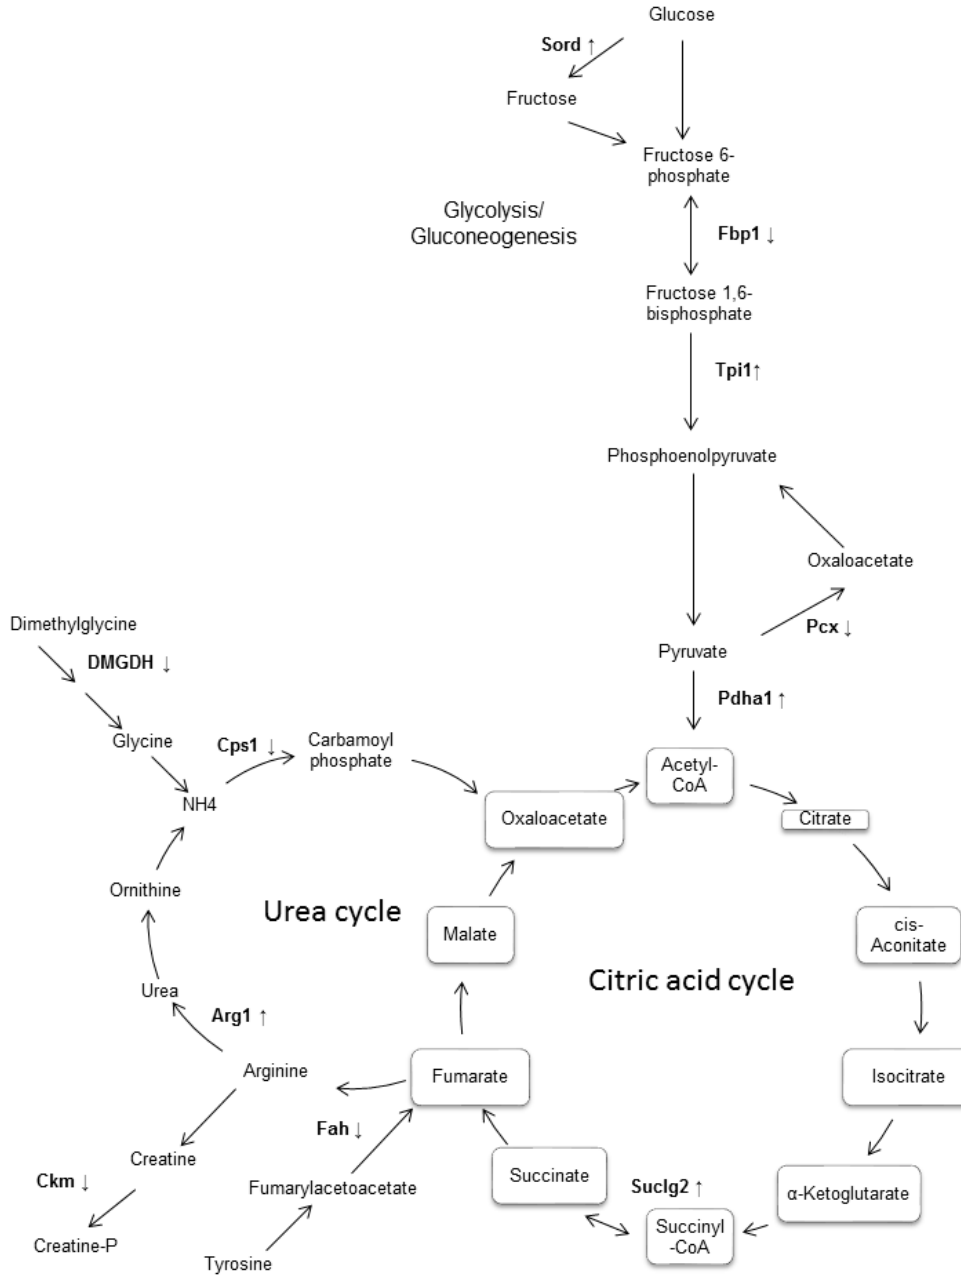
Figure 3. Representative diagram of the main metabolic pathways which involved some of differentially expressed proteins in the liver of db/db diabetic mouse. It was observed that most of the differentially expressed enzymes were found to participate in the metabolic pathways of gluconeogenesis/glycolysis, as well as in the metabolism of fructose and in the citric acid cycle. Although no enrichment of the urea cycle was observed, this was included because it binds both to the citric acid cycle and to the metabolic pathways of the enriched amino acids found. The enzymes that were found differentially expressed in this work are shown in bold, with an arrow indicating if it was increased or